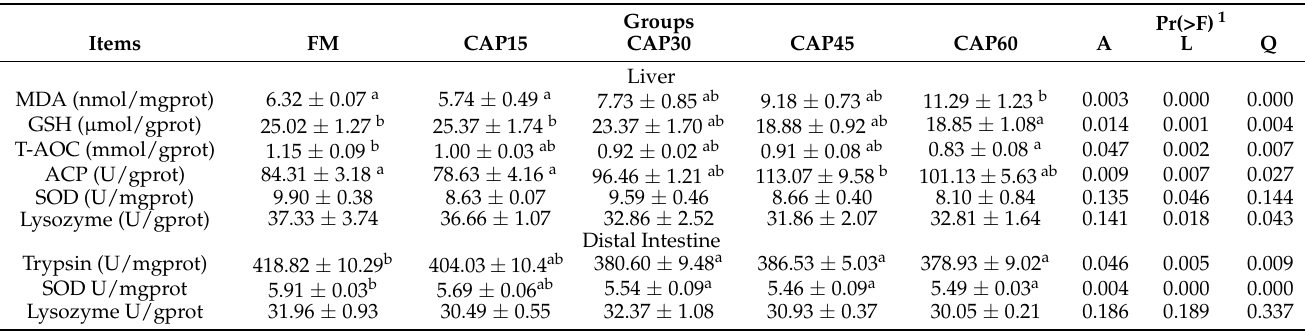
Table 6. Biochemical indices and enzyme activities in liver and distal intestines of pearl gentian grouper-fed gradient substitution of fishmeal in the diet with CAP.